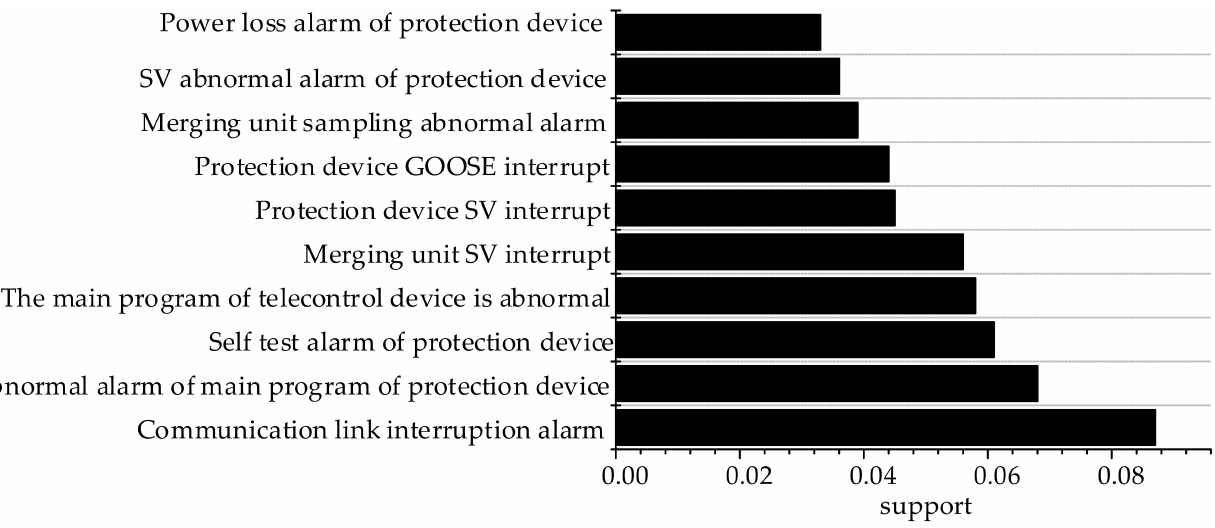
Figure 4. Alarm signal